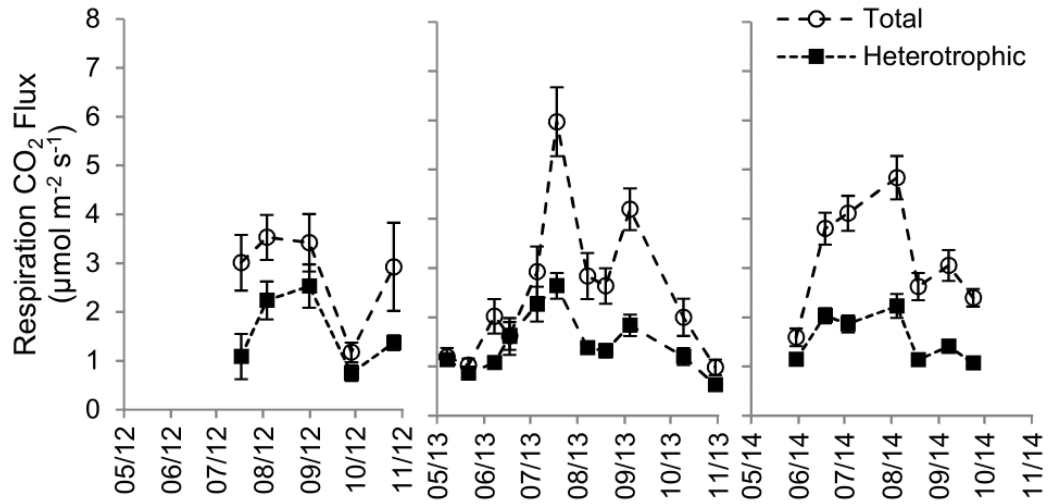
Figure 5. Seasonal variation in mean total below-ground and heterotrophic below-ground soil respiration CO flux (μmol m -2 s -1 ). Error bars are one standard error, n = 18 in 2012 and 2014 (Aclands and Spooners) 2 and n = 9 in 2013 (Spooners only).